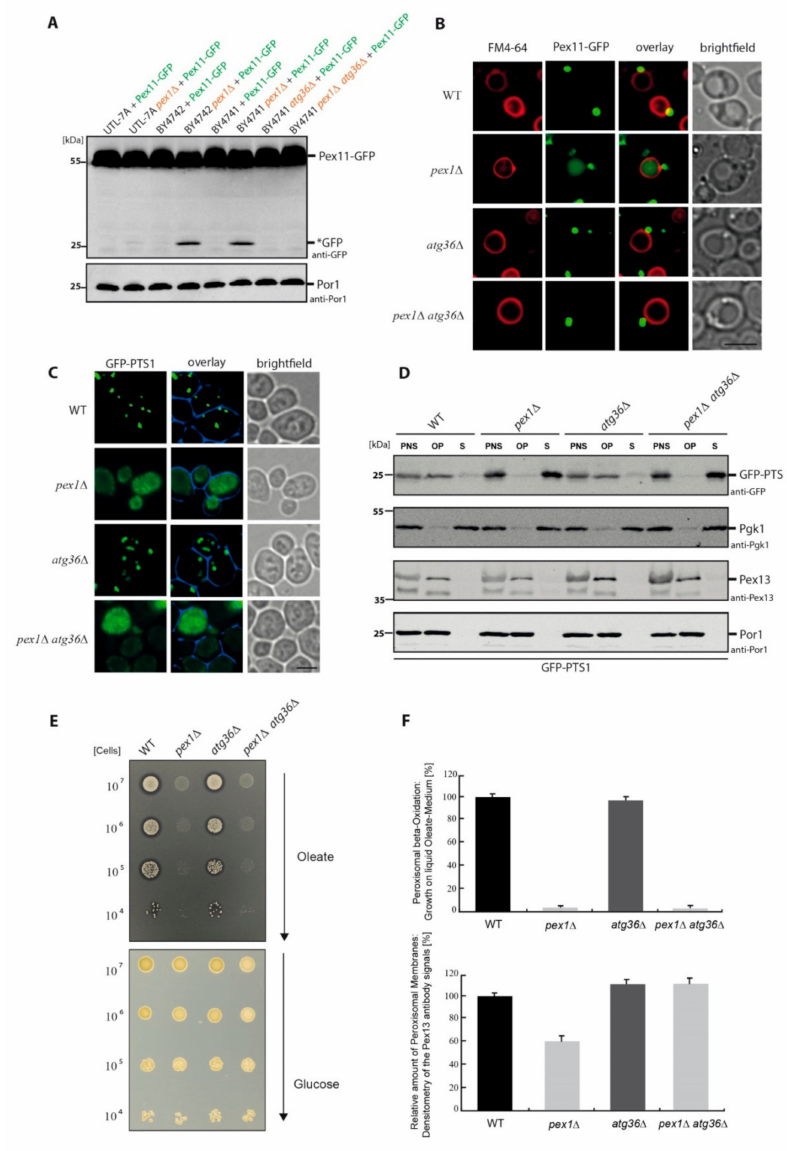
Figure 1. The matrix protein import defect in PEX1 -deficient cells occurs independently of pexophagy. ( A ) The indicated di ff erent Saccharomyces cerevisiae wild-type (WT) strains were transformed with the peroxisomal membrane protein Pex11 genetically fused to green fluorescent protein